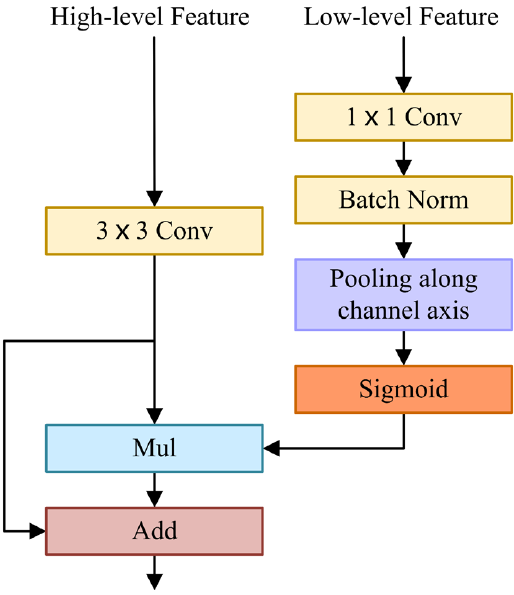
Figure 3. Feature Fusion Module.